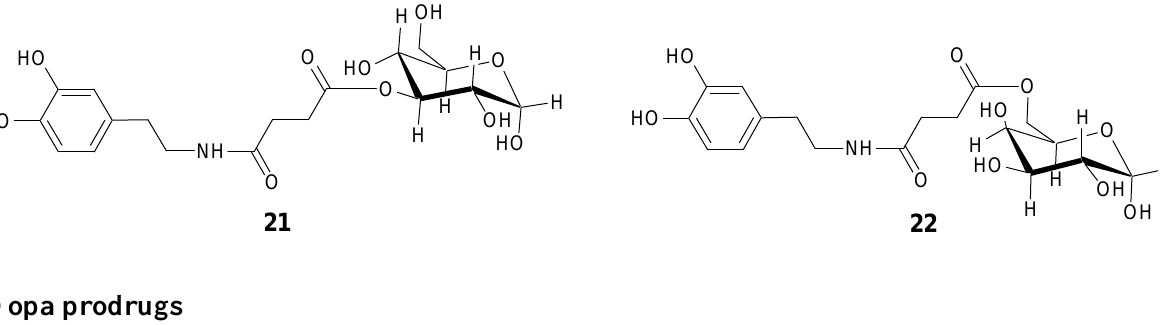
Figure 3 . Chemical structures of glycosuccinyl-derivatives of